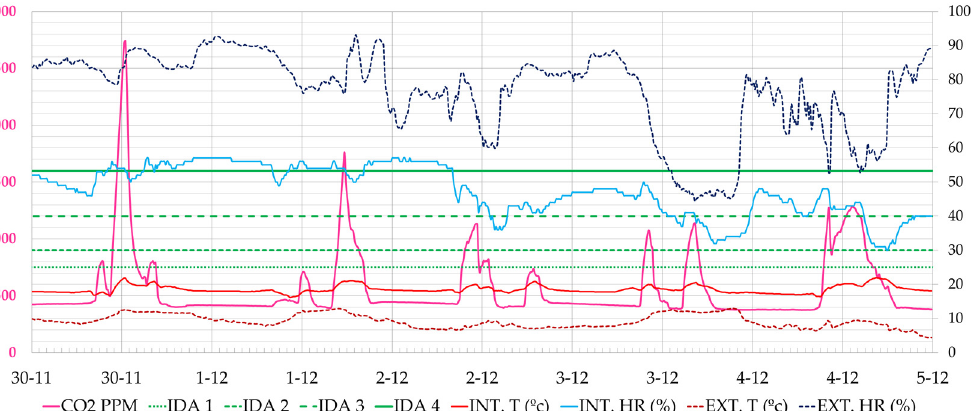
Figure 11. Evolution of CO 2 concentration, interior and exterior temperature and relative humidity in classroom A 1.1, during the week 2020-11-30 to 2020-12-05 (Phase I). Source: authors.